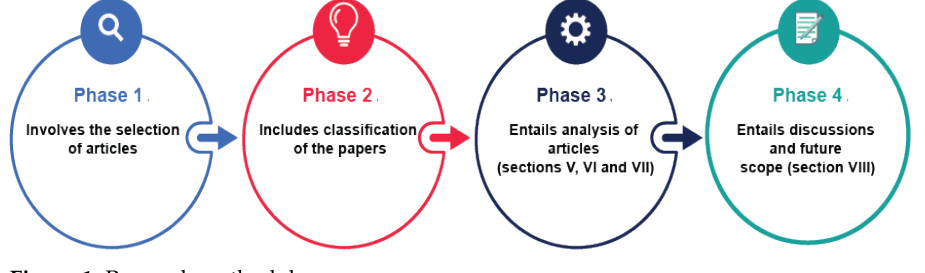
Figure 1. Research